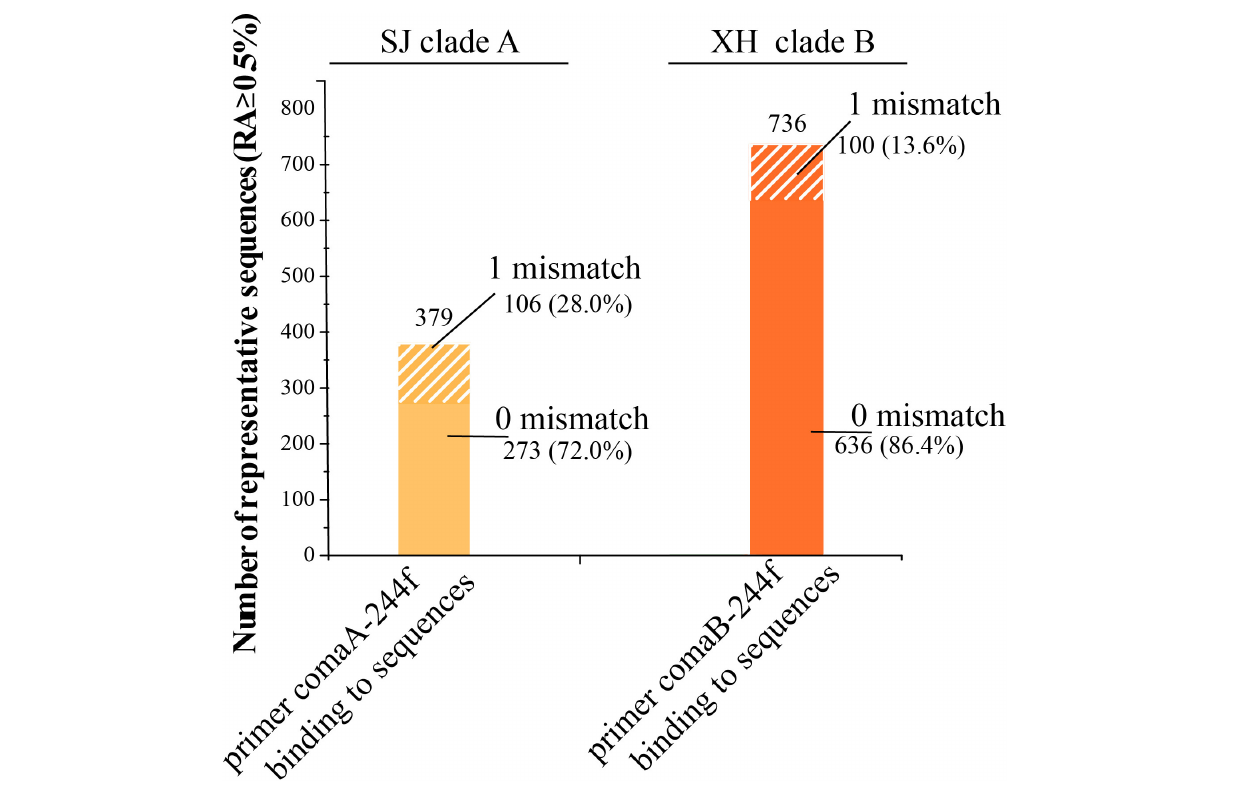
FIGURE 5 | Primer-target mismatch analysis for former primer comaA/B-244f and the missed comammox amoA sequences (clade A in SJ and clade B in XH samples) amplified by Ntsp-amoA 162F/359R (RA > 0.5%). 0 and 1 mismatch indicate former primer comaA/B-244f binding to corresponding region in comammox amoA gene sequences amplified by Ntsp-amoA 162F/359R without base mismatch and with 1 base mismatch,